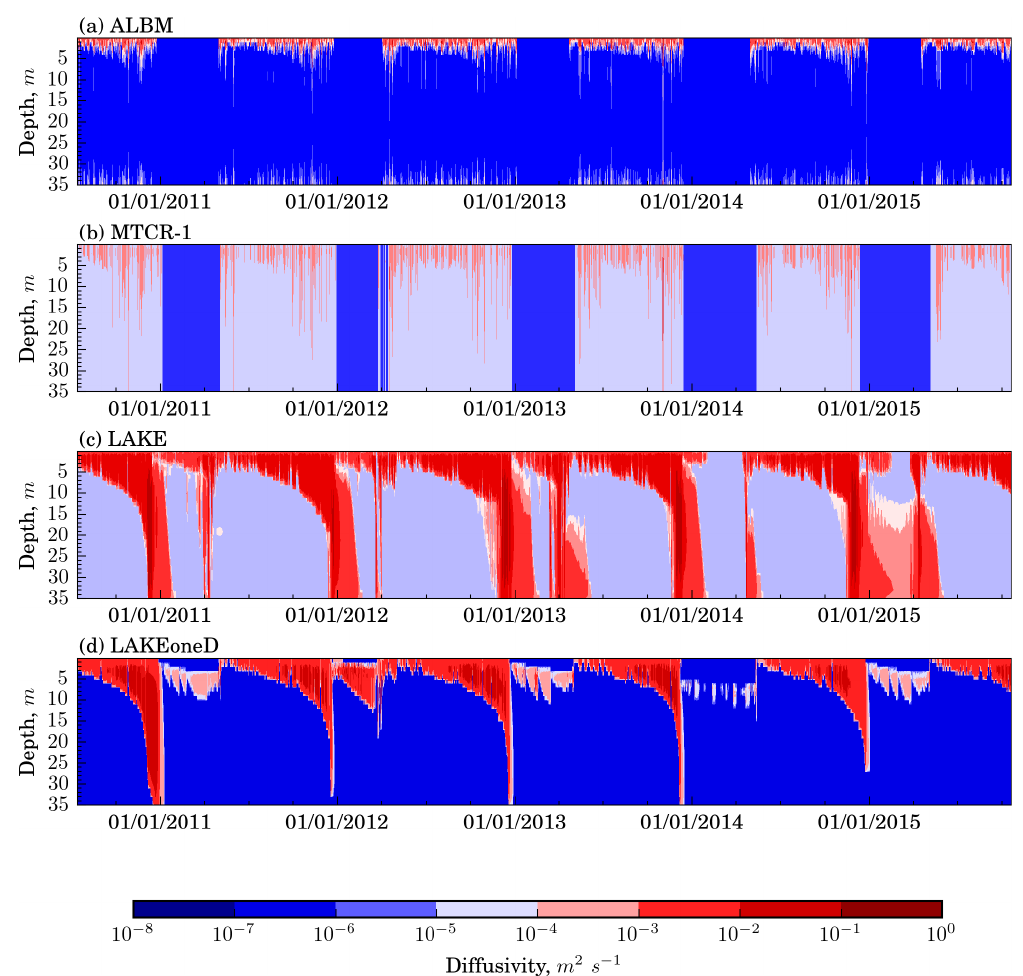
Figure 5. Time–depth distribution of the ED in Harp Lake (14 July 2010–19 October 2015), RefSim model